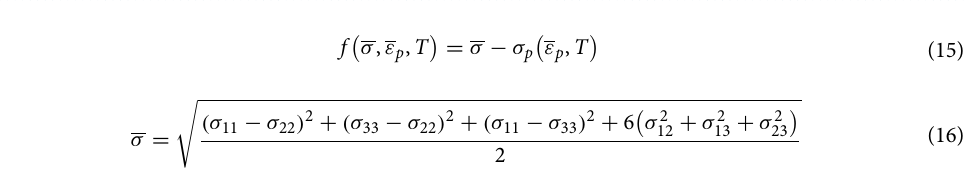
Figure 6. The flow stress obtained using GPR-based model with respect to the plastic strain at the temperature of ( a ) 20 °C, ( b ) 100 °C, ( c ) 150 °C, ( d ) 200 °C, ( e ) 250 °C and ( f ) 300